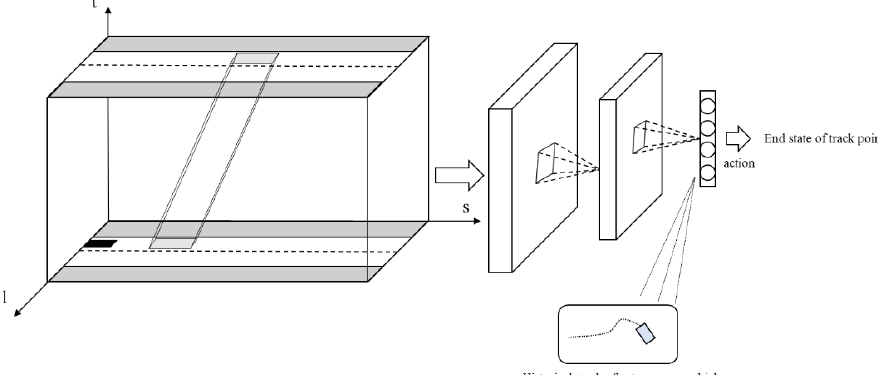
Figure 4. Strategic network structure diagram.